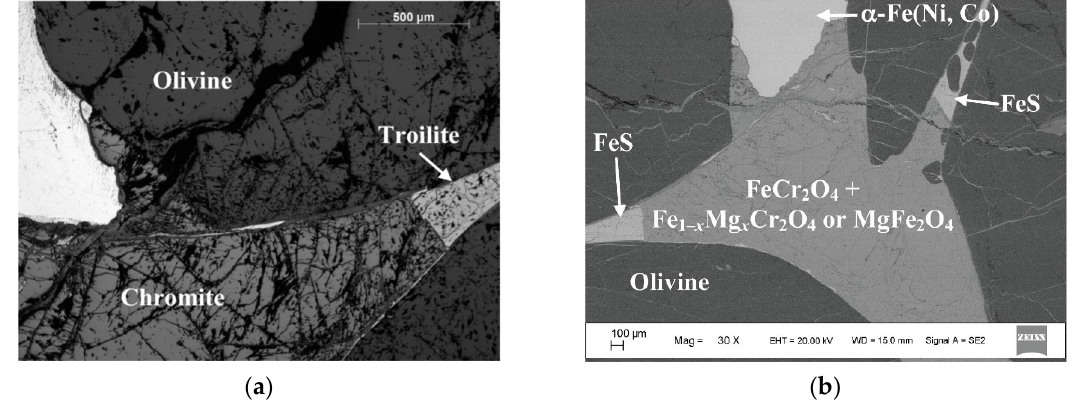
Table 3. Mössbauer parameters for spinels found in the bulk ordinary chondrites in comparison with data obtained for synthetic spinels.